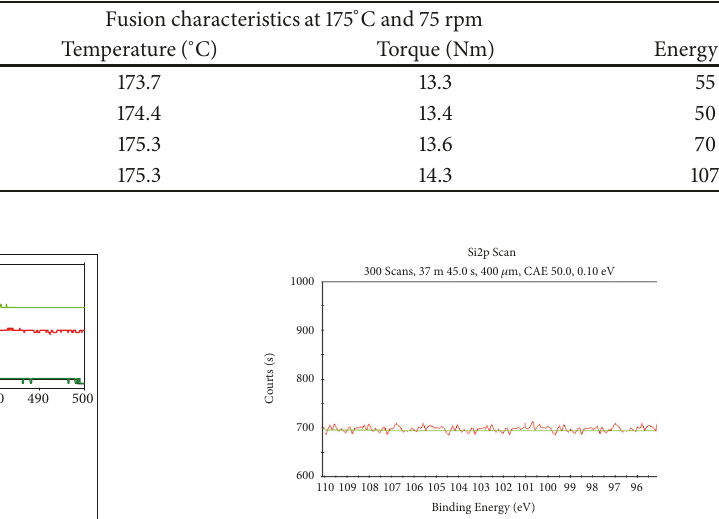
Table 3: Fusion characteristics of neat PVC and PVC/WF composites.